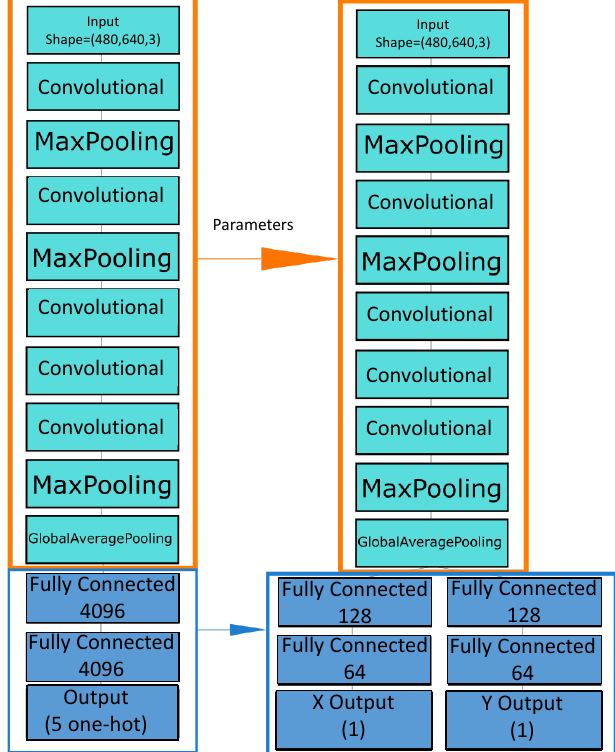
Figure 4. Transfer learning process addressed from the CNN for the room retrieval task ( left ) to develop the CNN that estimates the the X , Y coordinates ( right